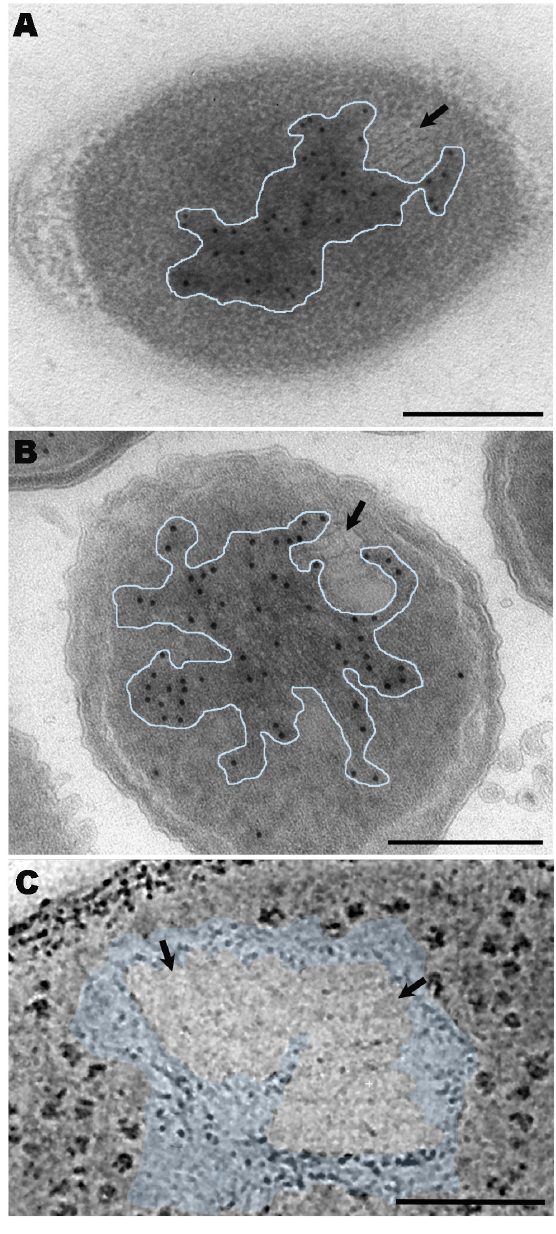
Figure 6. TEM immunolabeling and tomographic studies analyzing the proximity between stacks and DNA in TSA- grown cultures of P. deceptionensis M1 T . (A) DNA immunolabeling on 60 nm HM23 Lowicryl sections from samples processed by HPF-FS. (B) DNA immunolabeling on a 60 nm Tokuyasu sections. (A–B) Stacks were observed very close to and partially embedded in to the gold-labeled nucleoid area (see black arrows pointing stacks and outlined areas corresponding to the nucleoids). (C) A 2 nm tomogram slice of a bbif-filtered tomogram reconstructed from a 250 nm Epon section of a sample processed by HPF-FS. Two contiguous stacks are observed (black arrows) embedded in the nucleoid area (see colored area). Scale bars = 250 nm. doi: